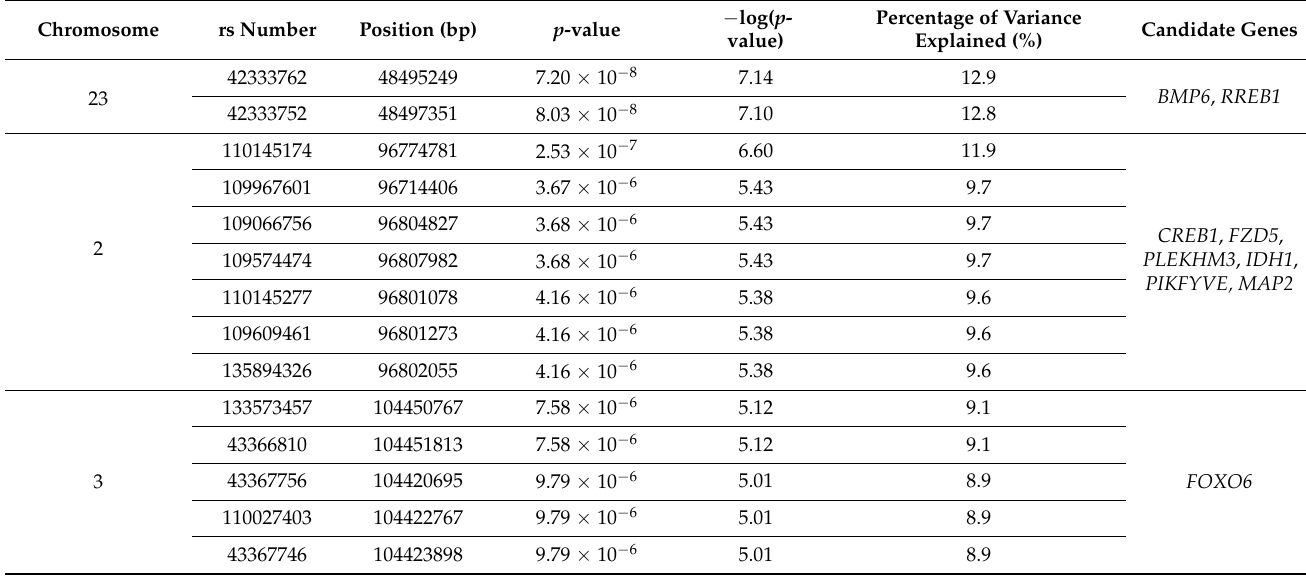
Table 1. Chromosome, rs number, position, p -value, − log( p -value), percentage of variance explained, and the candidate genes for significant SNPs associated with the AFC.